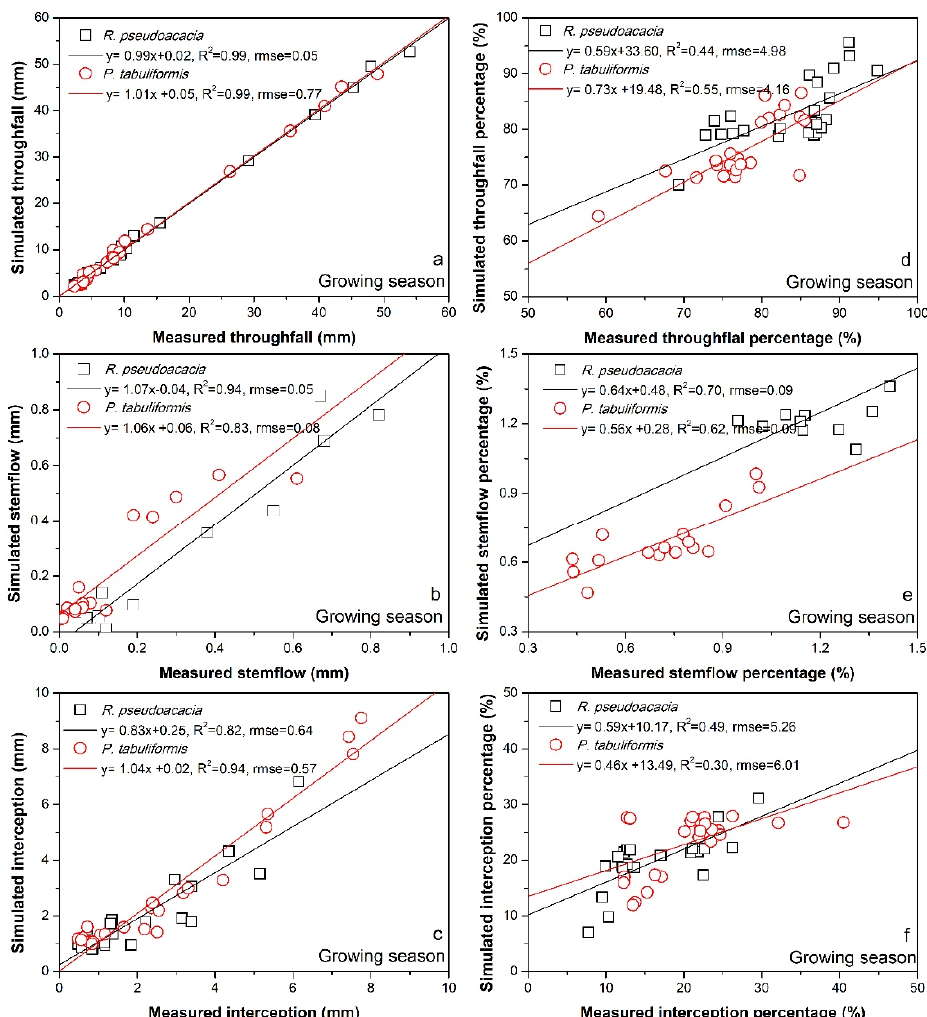
Figure 5. Comparison between the measured and simulated rainfall partitioning components for R. pseudoacacia ( a – c ) and P. tabuliformis ( d – f ) during the growing season of 2016.